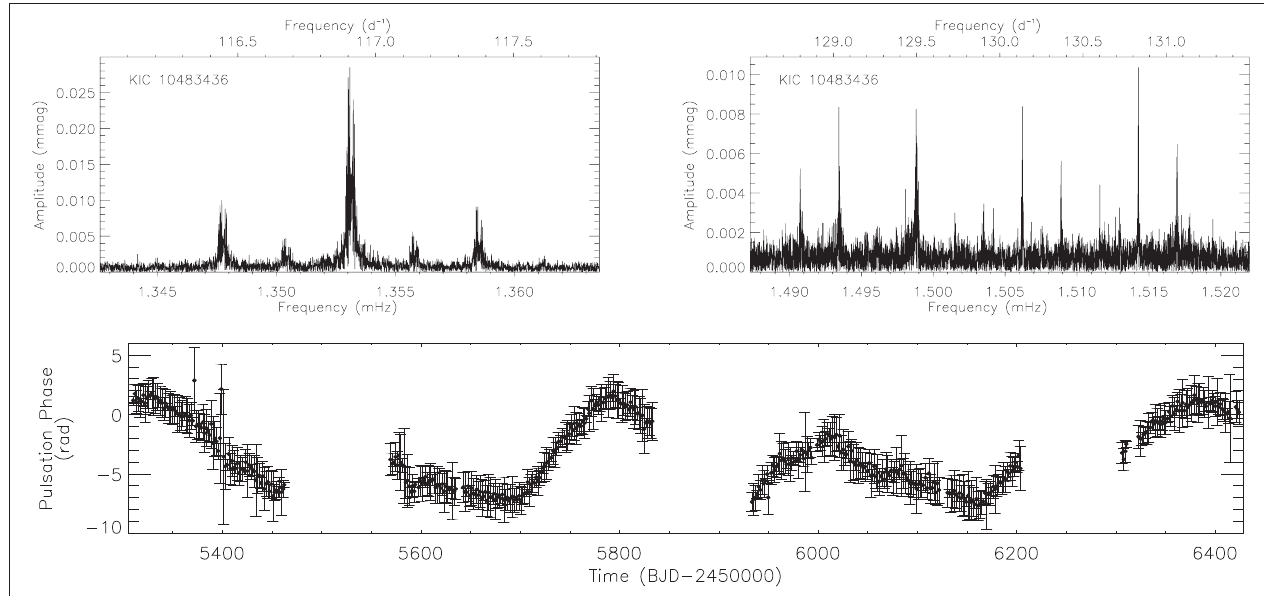
FIGURE 5 | (Top) Amplitude spectra of KIC10483436 showing the pulsation frequencies in this star. The left plot shows a quadrupole quintuplet with the peaks separated by the rotation frequency (2.670 µ Hz, P = 4.303d). The right panel shows many modes with rotational sidelobes, making mode identification less straightforward. (Bottom) The phase variation of the principal mode in this star ( ∼ 1.353 µ Hz).